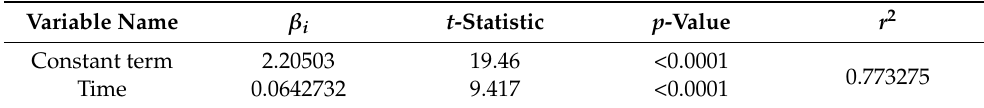
Table 4. Real price of wild mushrooms against time.